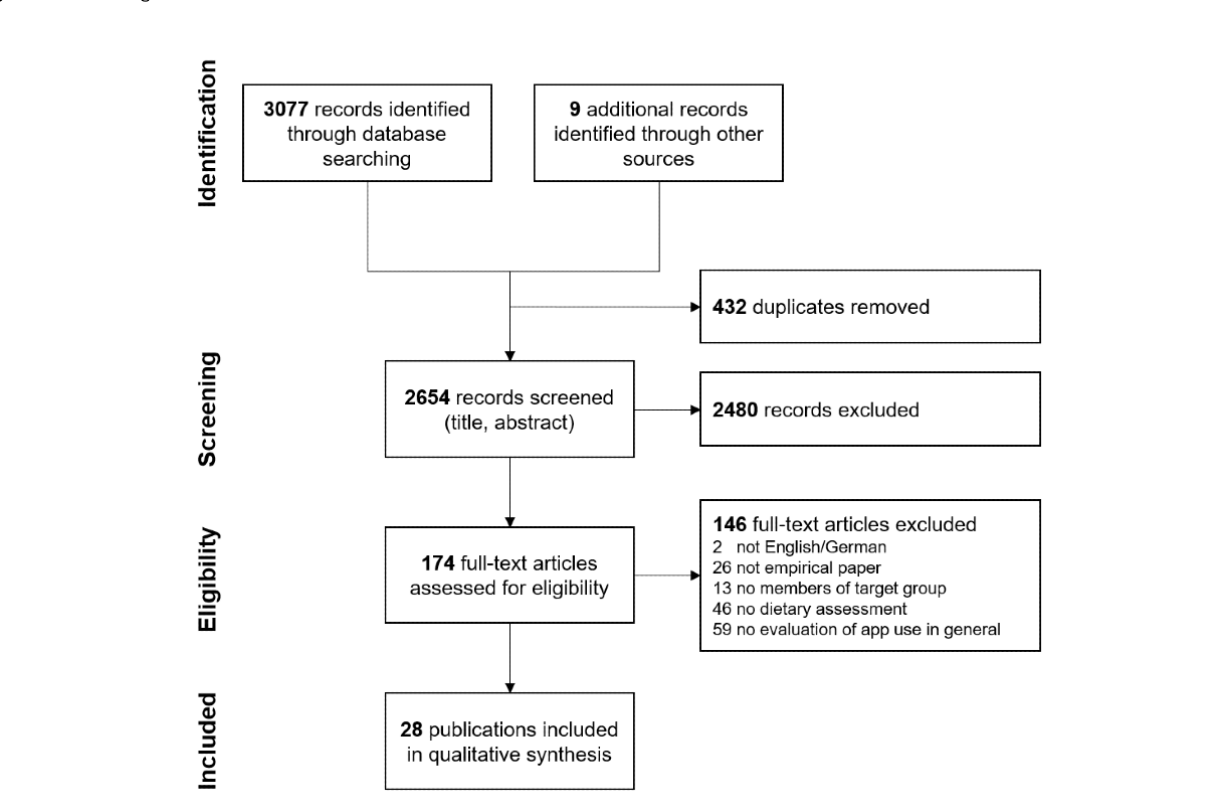
Figure 1. Flow diagram of article